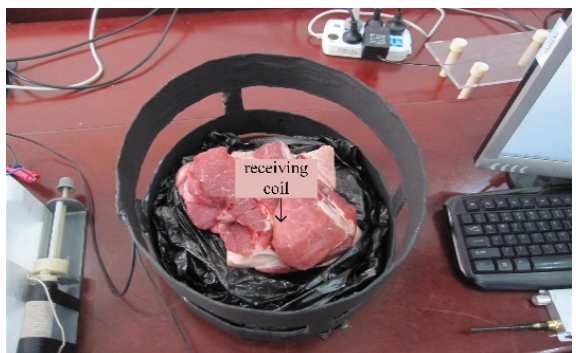
Figure 9. The Setup for measurement of mutual inductance when the receiving coil is tightly surrounded by biological tissues.